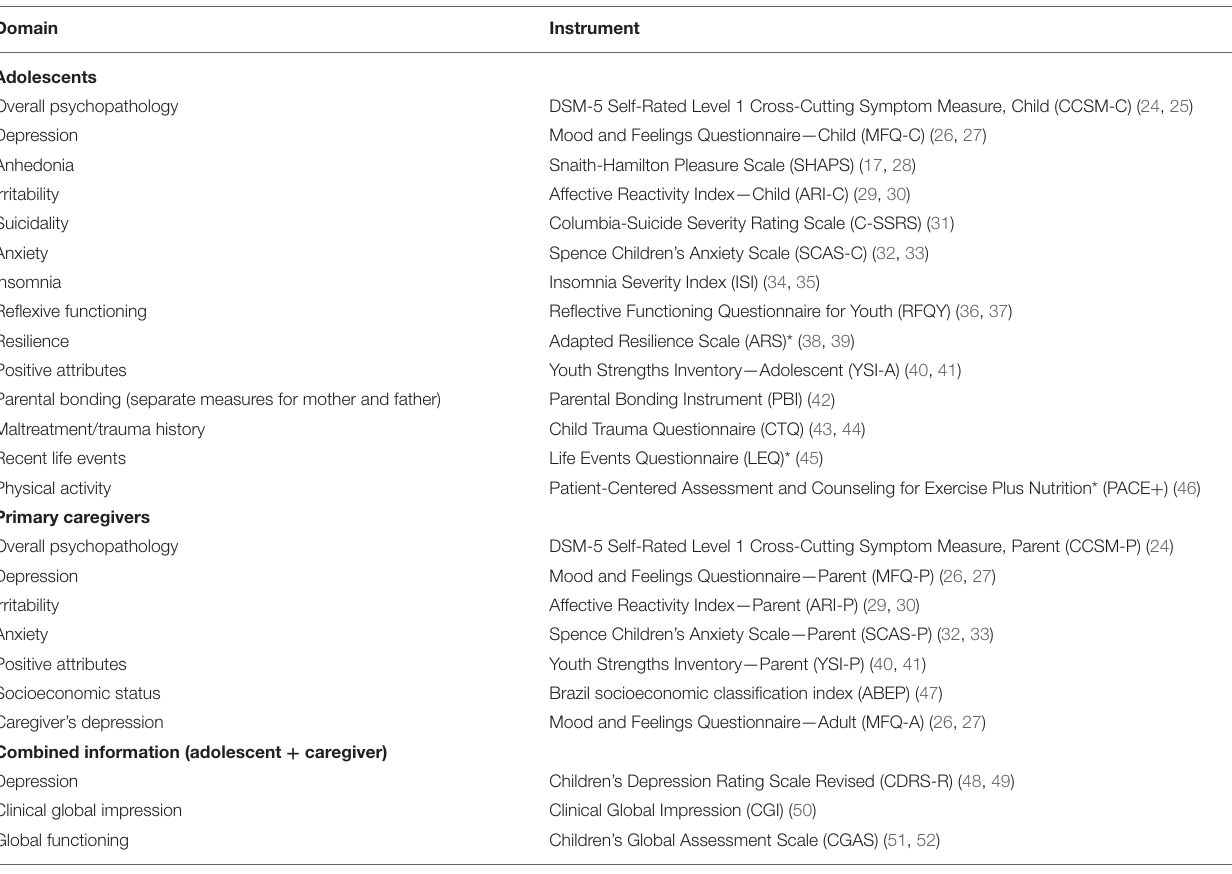
TABLE 1 | Domains and instruments used for phenotypic characterization of the IDEA-RiSCo